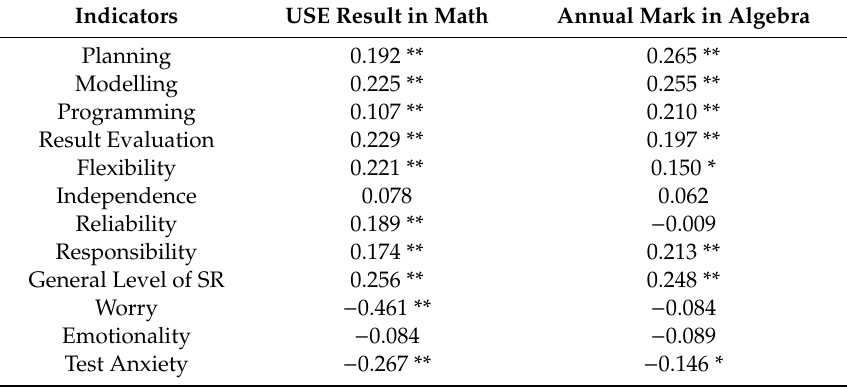
Table 2. The correlation coe ffi cients for the indicators of self-regulation, test anxiety, and mathematic achievement (Unified State Examination (USE) result and the annual mark in algebra) (N = 231).